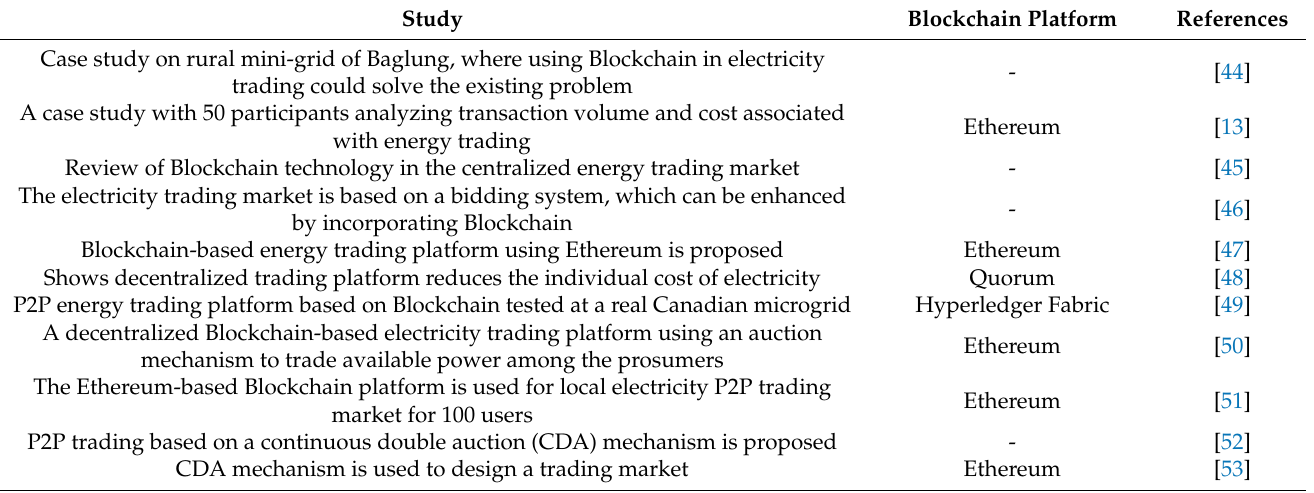
Table 2. Summary of publications employing Blockchain technology for energy trading.